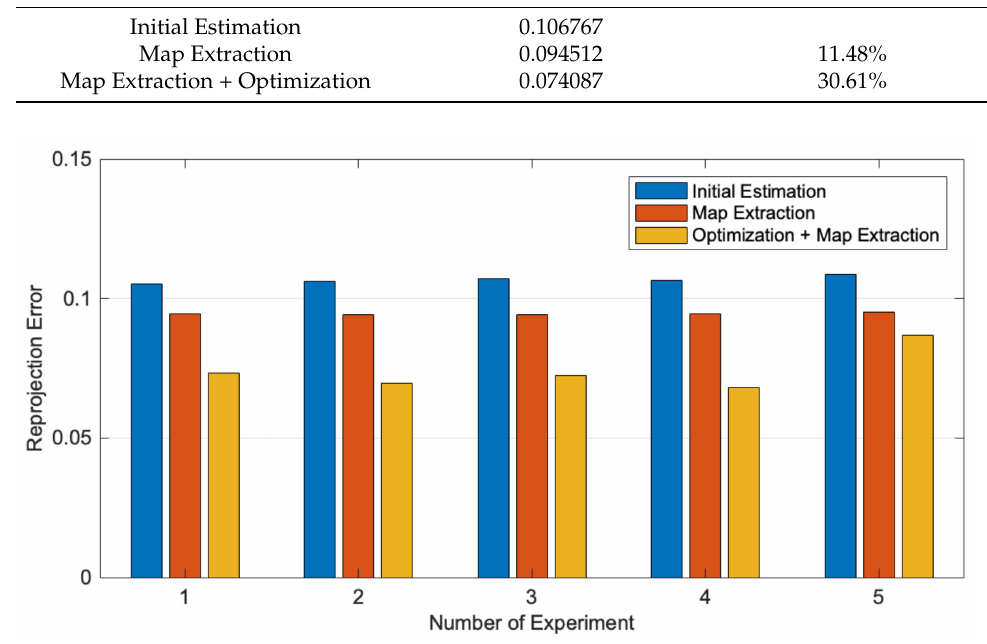
Figure 12. Reprojection errors’ distribution in ablation